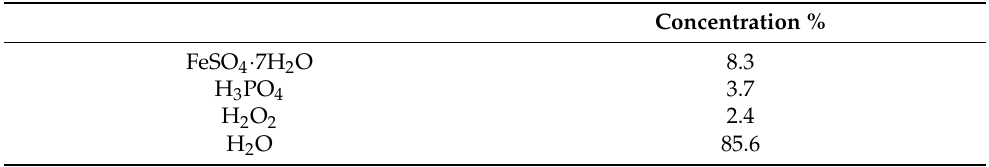
Table 2. Compositions of the